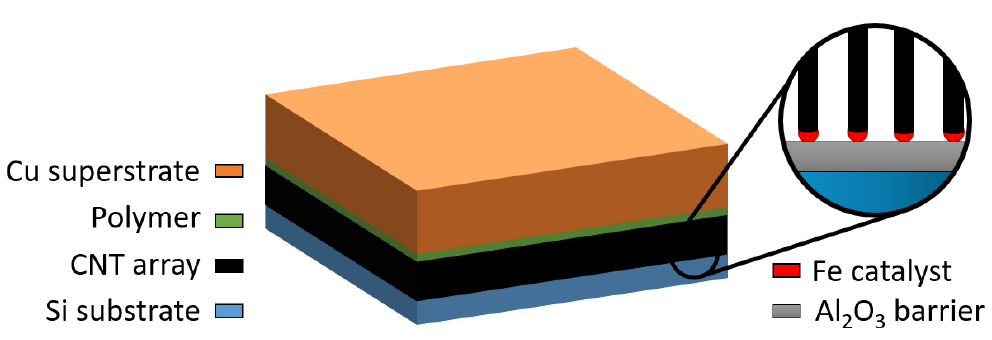
Figure 1. Illustration of the thermal interface fabricated for this project and the materials configuration.